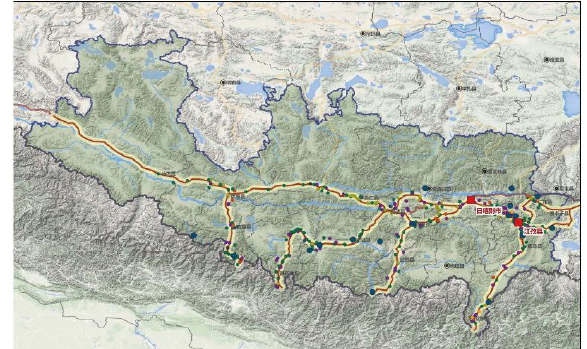
Figure 2. GIS analysis of the cultural routes in Shigatse Region